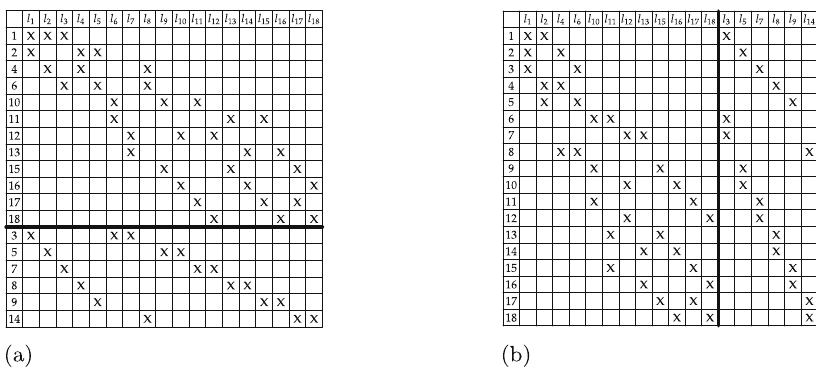
Figure 18: Two dual 18 3 144 - con fi gurations inducing non - isomorphic triangular matroids. ( a ) 18 L , ( b ) 18 P .